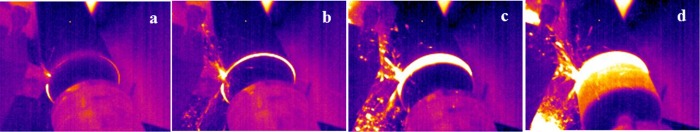
Thermal infrared diagram of temperature field in the cutting area: a. 0.1s, TMax:34.7°C; b. 2s TMax:52.1°C; c. 4s, TMax:54.4°C; d. 7s, TMax:63.8°C.